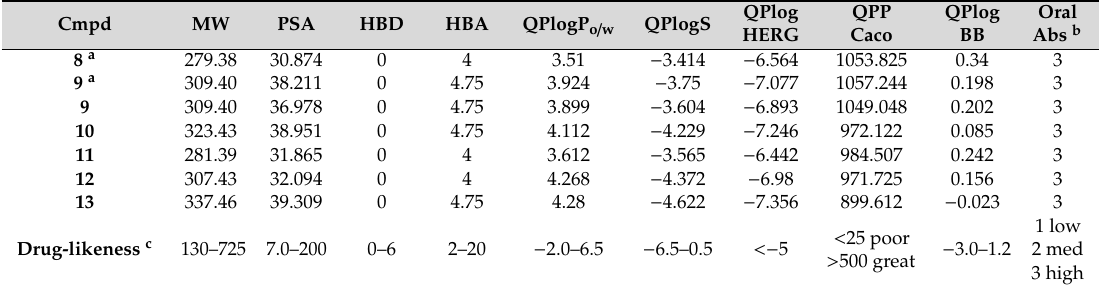
Table 2. Relevant descriptors and properties predicted with QikProp.